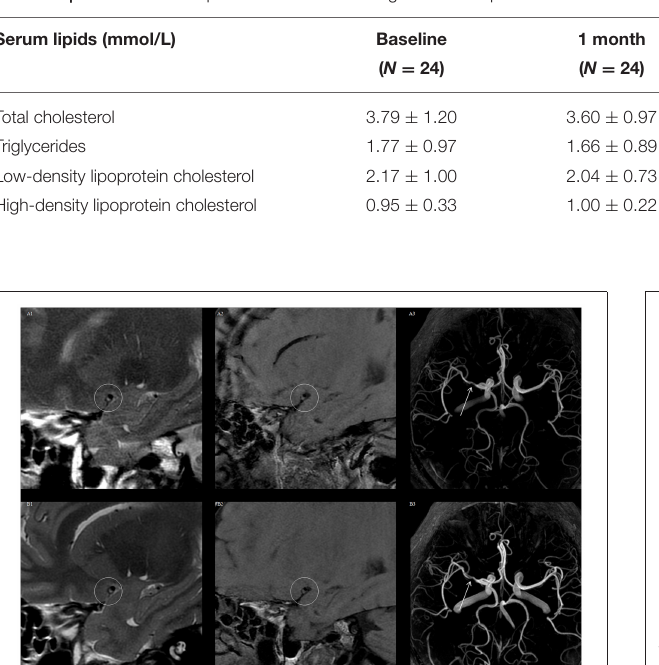
TABLE 3 | Patients’ serum lipid concentrations during the follow-up.